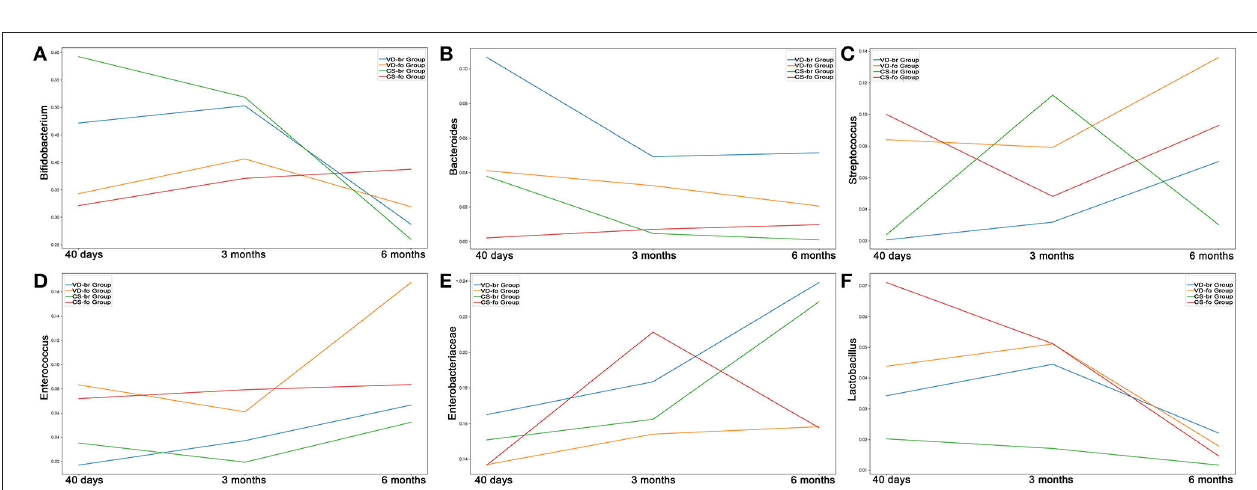
FIGURE 5 | The relative abundance curves of (A) Bifidobacterium , (B) Bacteroides , (C) Streptococcus , (D) Enterococcus , (E) Enterobacteriaceae and (F) Lactobacillus in different groups from 40 days to 6 months old. Y-axis represents the median line of relative abundance. (A) In CS-br group, Bifidobacterium decreased significantly in 6 months of age, compared with that in 40 days ( p = 0.0313) and 3 months of age ( p = 0.0469). In 40 days of age, there were significant differences between VD-br and CS-fo group ( p = 0.0294), CS-br and CS-fo group ( p = 6.789E-05), and CS-br and VD-fo group ( p = 0.0057). (B) In VD-br group, Bacteroides decreased significantly in 3 months of age, compared with that in 40 days ( p = 0.0078). In VD-fo group, Bacteroides decreased significantly in 6 months of age, compared with that in 3 months ( p = 0.0353). In 40 days of age, there were significant differences between CS-fo group and other groups (vs. VD-br p = 0.0003; vs. VD-fo p = 0.0189; vs. CS-br p = 0.0004). In 3 months and 6 months of age, Bacteroides in VD-br group was different from CS-fo group (3m p = 0.0179; 6m p = 0.0240). (C) In VD-br group, Streptococcus increased significantly in 6 months of age, compared with that in 40 days ( p = 0.0234) and 3 months ( p